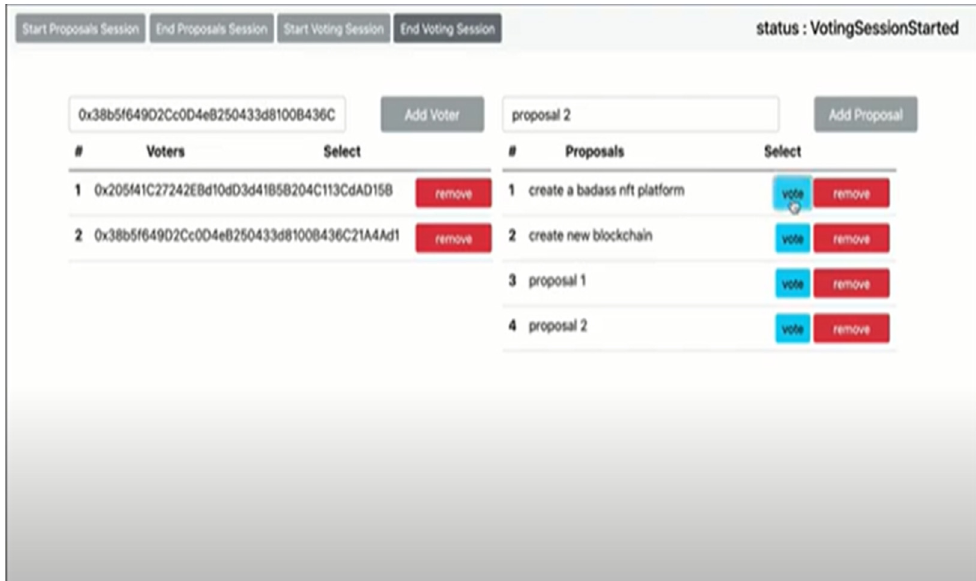
Figure 11. Voting interface.